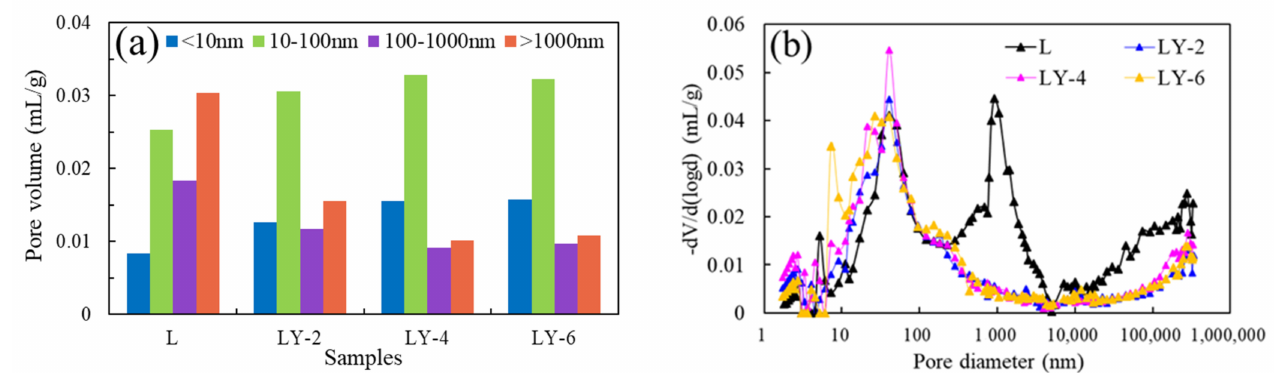
Figure 12. Pore size distribution in combination of mercury intrusion/extrusion porosimetry (MIP) and nitrogen absorption (NA): ( a ) pore volume with different pore size ranges, ( b ) different pore sizes corresponding to incremental pore